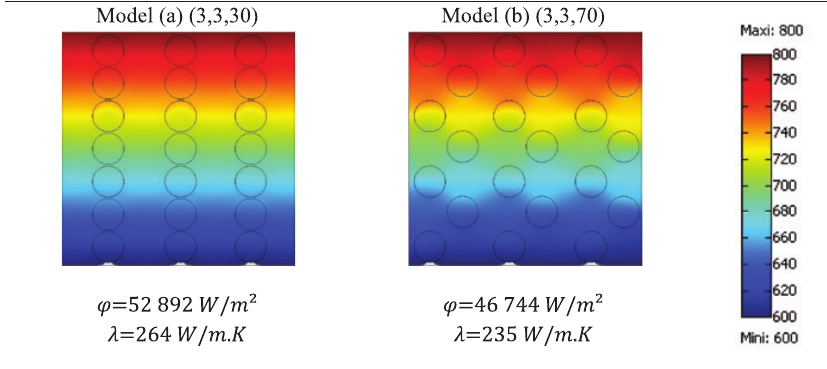
Fig. 8: Influence of paths of flow on the heat transfer and thermal conductivity